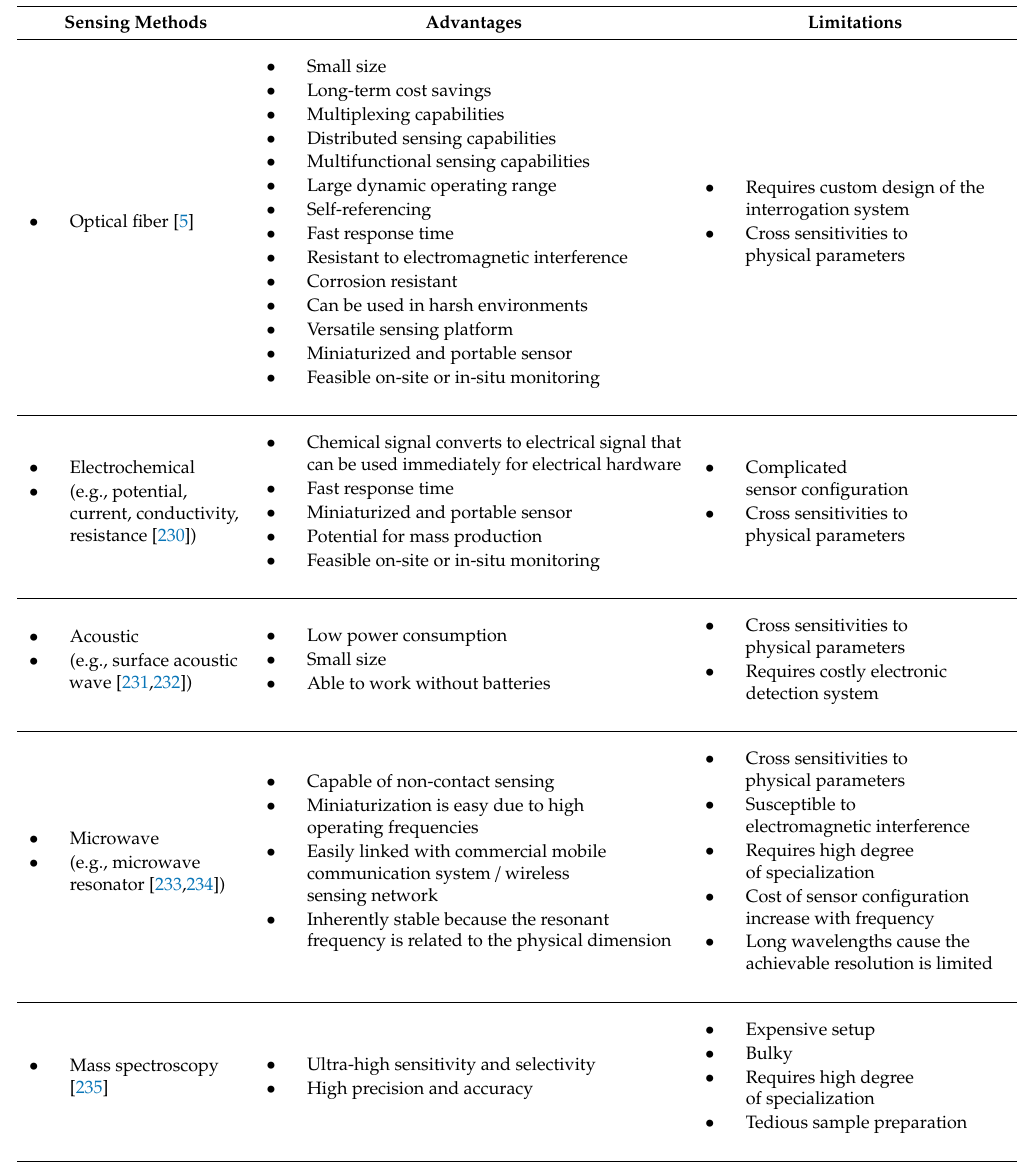
Table 8. Advantages and limitations of di ff erent sensing methods for environmental and biological sensing